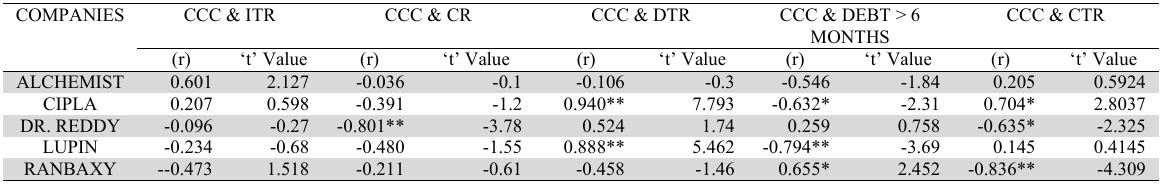
Note: Figures in the parentheses indicate ‘t’